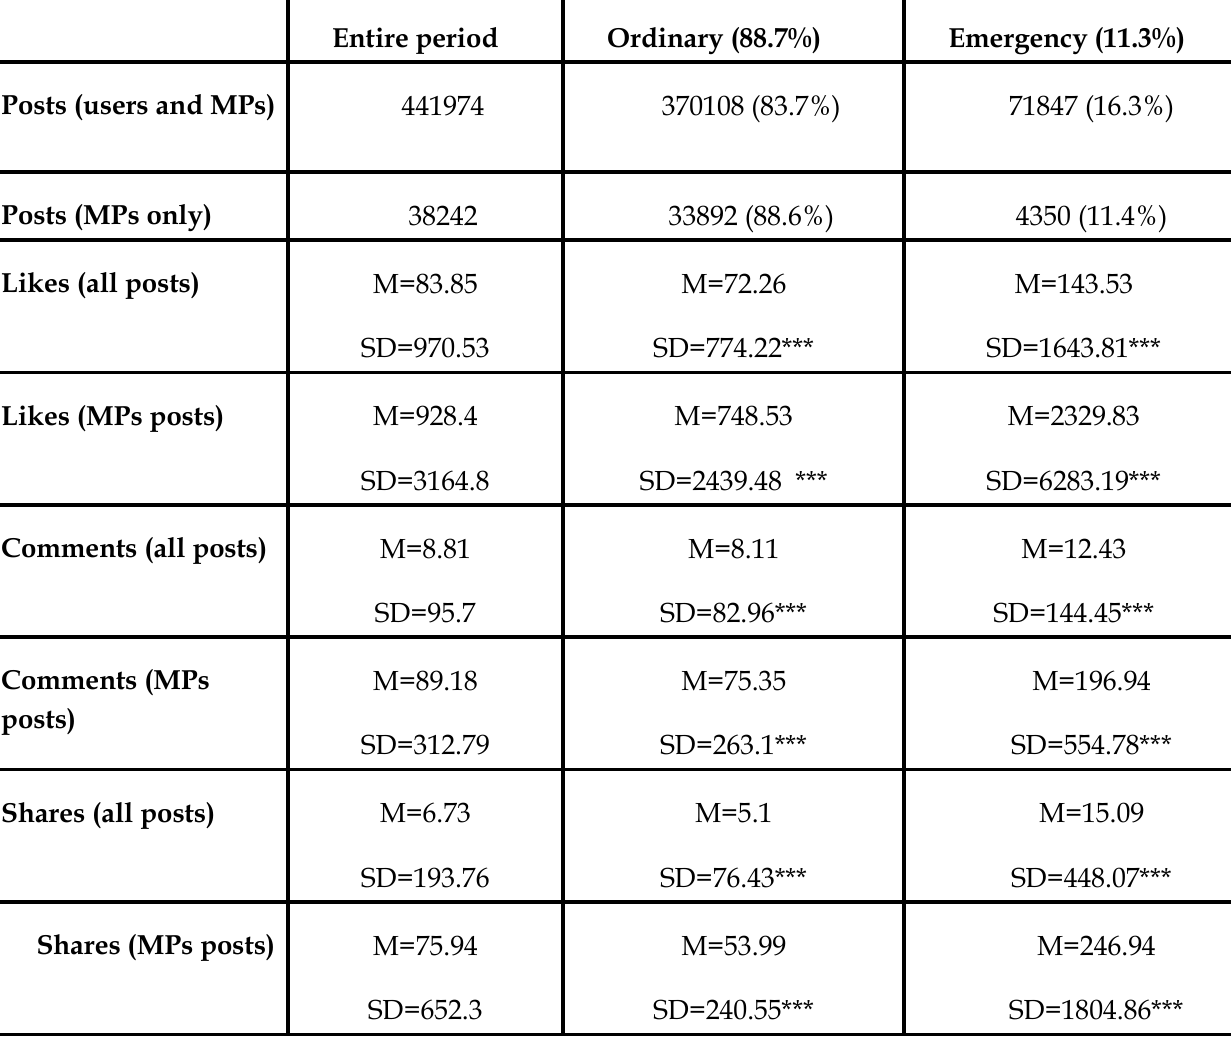
Table 1: Posts and Engagement with Posts during Emergency and Ordinary Periods Entire period Ordinary